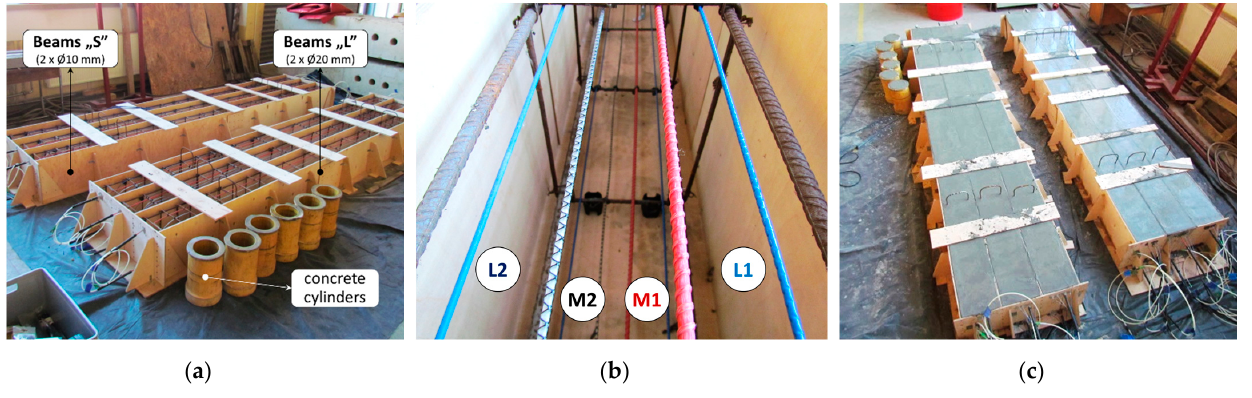
Figure 15. Spatial visualisation of the concrete beams equipped with embedded DFOS tools.